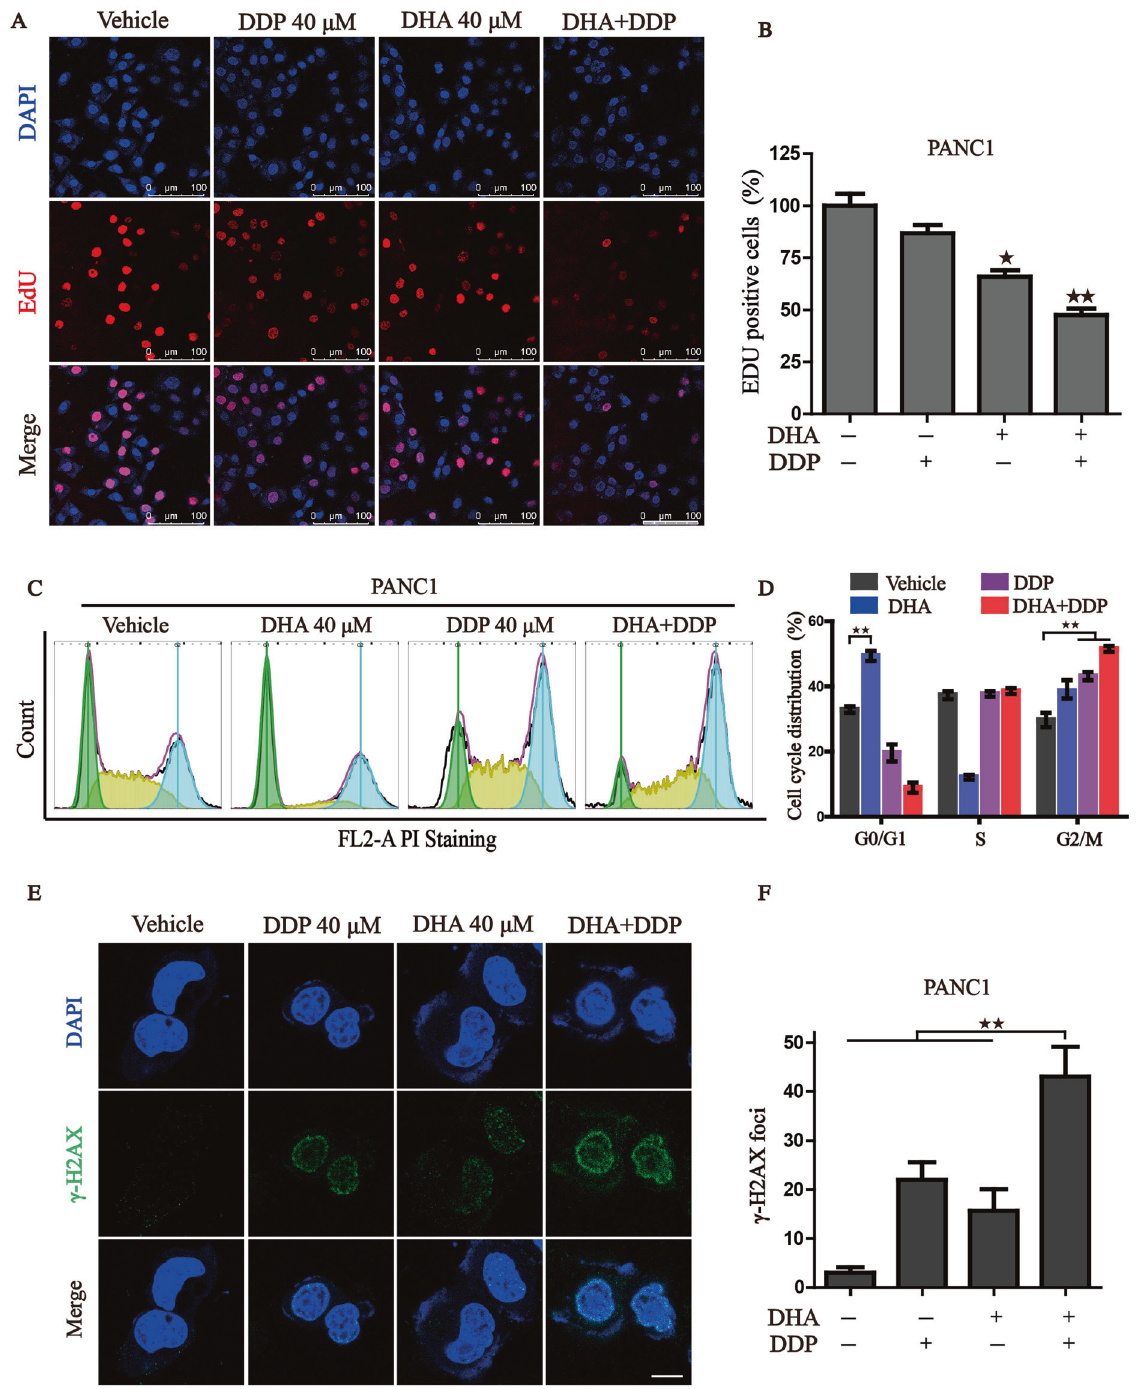
Fig. 2 Combinative treatment of DHA and DDP inhibits proliferation and induces DNA damage in pancreatic cancer cells. A , B Cell proliferation of PANC1 was detected by 5-ethynyl-2 ′ -deoxyuridine (EdU) incorporation assay under mono or combination treatment of DHA and DDP for 12 h. Representative images and statistical histograms are shown. Scale bar: 100 µm. C , D PANC1 cells were treated with mono or combination of DHA and DDP for 12 h, cell cycle distribution was determined by fl ow cytometry. E , F PANC1 cells were treated with mono or combination of DHA and DDP for 12 h and stained with γ -H2AX antibody. DAPI was used for nucleus staining. Images were acquired with confocal laser scanning microscopy. Quanti fi cation of γ -H2AX immuno fl uorescence was shown on the right. Scale bar: 10 µm. ★ P < 0.05, ★★ P < 0.01 versus